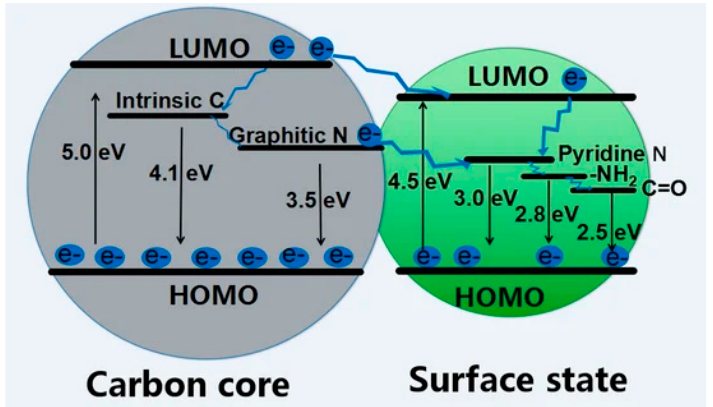
Figure 3. Scheme of the luminescence pathway and corresponding energy in graphene CDs with different core/shell ratio and surface functionalities. Reprinted with permission from [65] under CC BY 4.0.